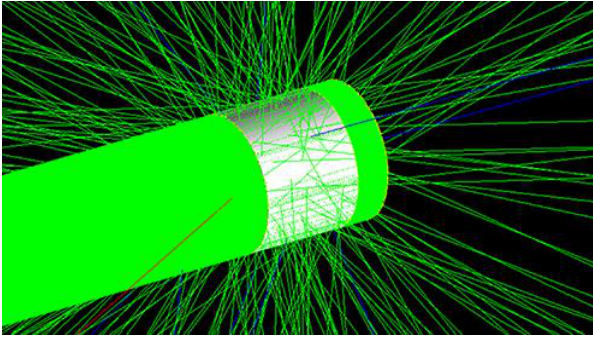
Figure 3. Track structure produced by neutrons irradiating SDD.